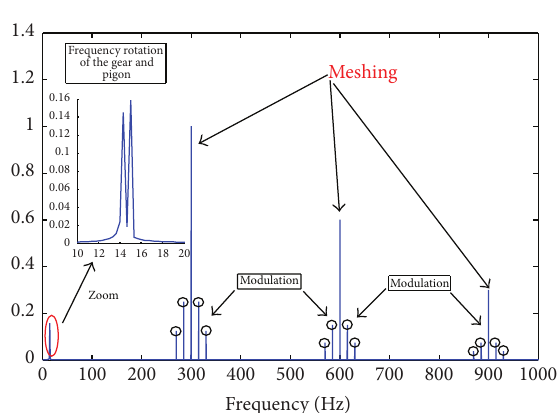
Figure 2: The simulated signal.